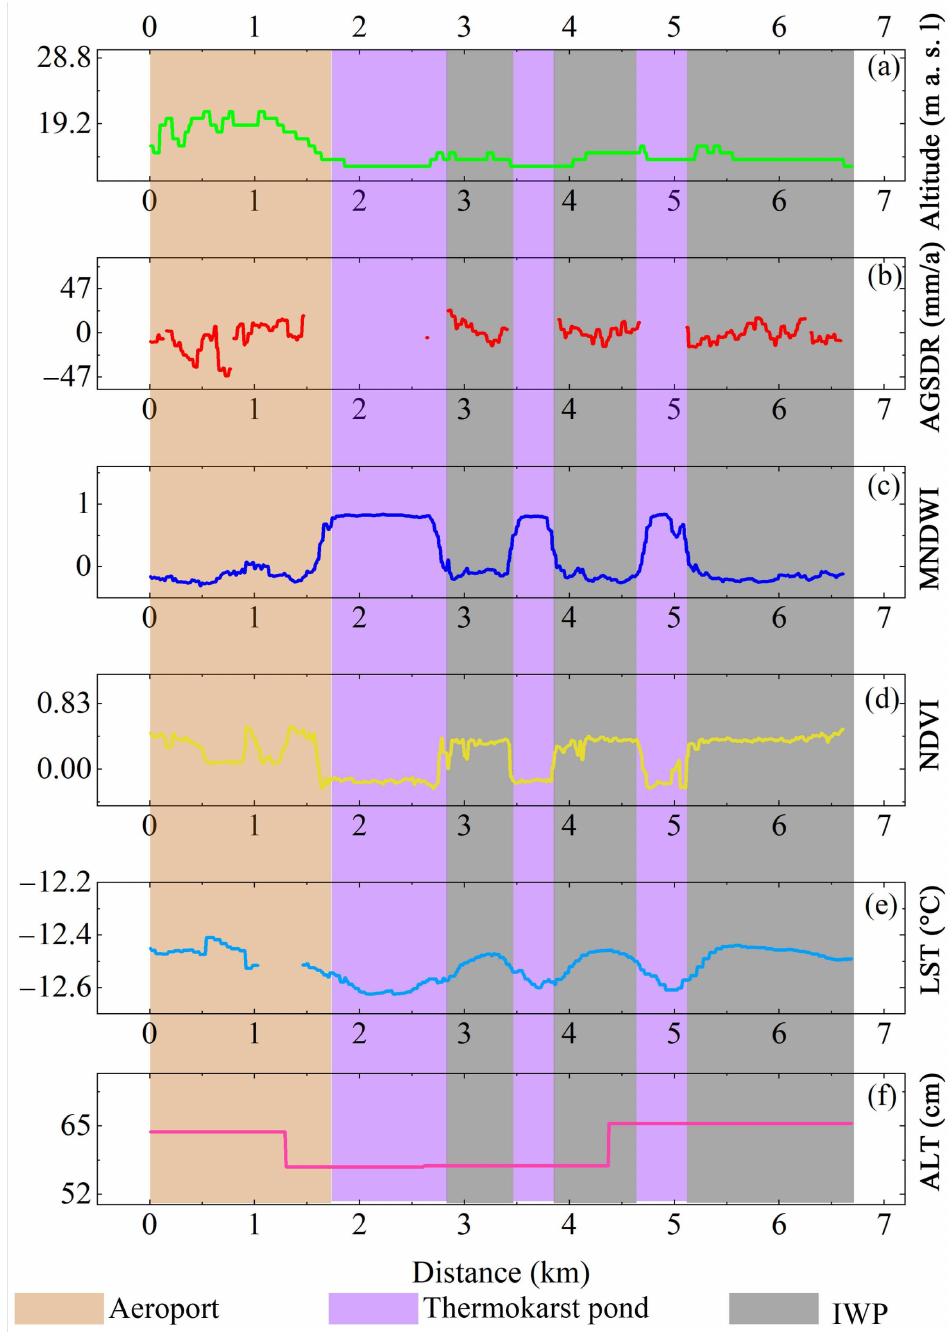
Figure 9. The W–E transect at Saskylakh, Anabarsky District, the Sakha Republic, Russia (the starting point of the W–E Transect is 0.0 km from the W–E Transect in Figure 2); Notes: ( a ) is the altitude (m a. s. l); ( b ) is the annual ground surface deformation rate (AGSDR, mm/a); ( c ) is the modified normalized difference water index (MNDWI, − 1~1). For thermokarst pond: MNDWI > 0; ( d ) is the normalized difference vegetation index (NDVI, − 1~1); ( e ) is the land surface temperature (LST, ◦ C); and ( f ) is the active layer thickness (ALT,